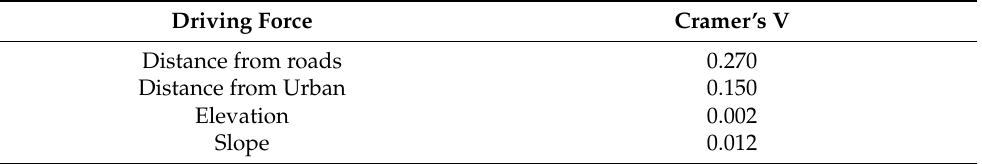
Table 6. Values for Cramer’s V.